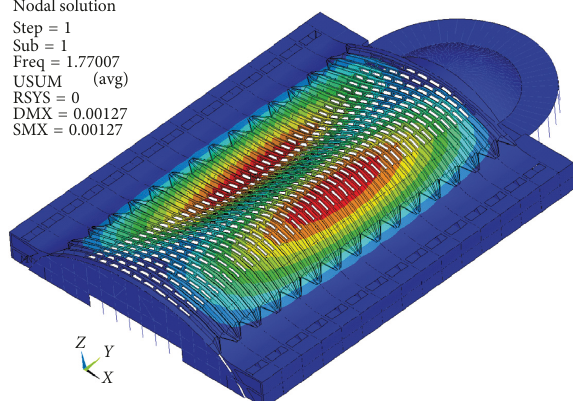
Figure 7: Mode 1 of Hall B (front view).